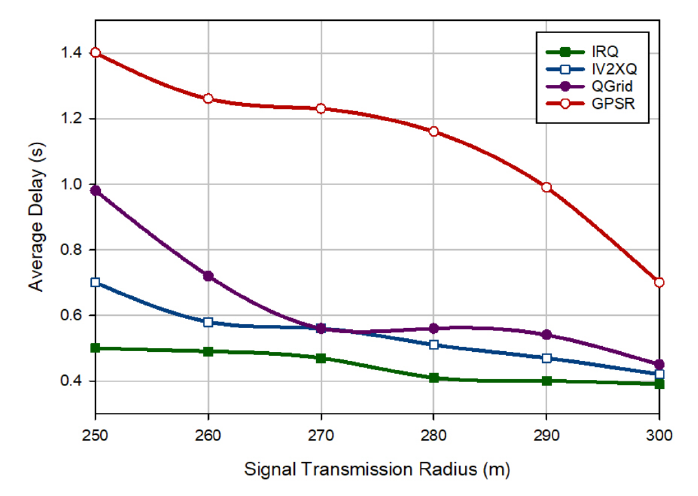
Figure 6. Comparison of delay in different routing methods based on PSR.